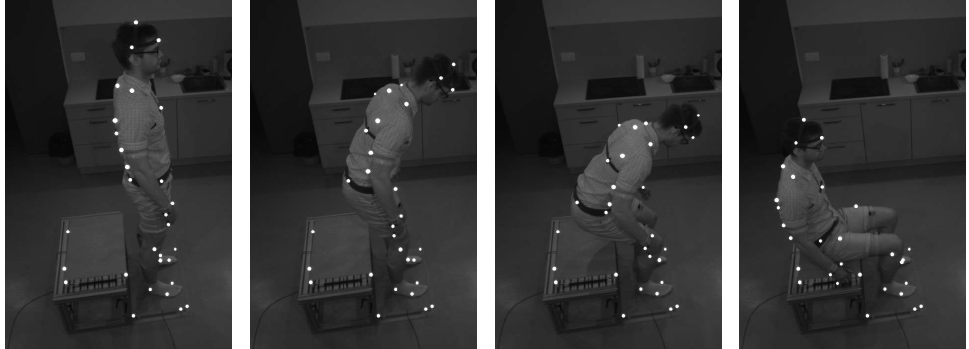
Figure 6. Photo sequence of a person sitting down on a bench while being recorded by the motion capture